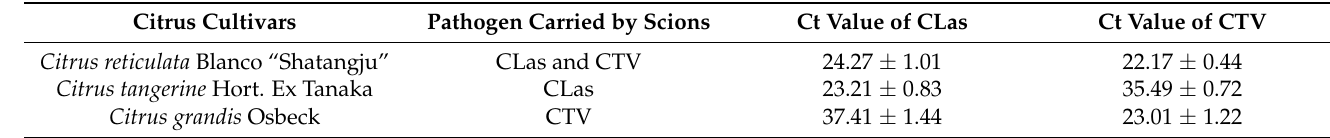
Table 1. Information of citrus seedlings grafted for CLas or CTV acquisition by D. citri . Citrus Cultivars Pathogen Carried by Scions Ct Value of CLas Ct Value of CTV Citrus reticulata Blanco “Shatangju” CLas and